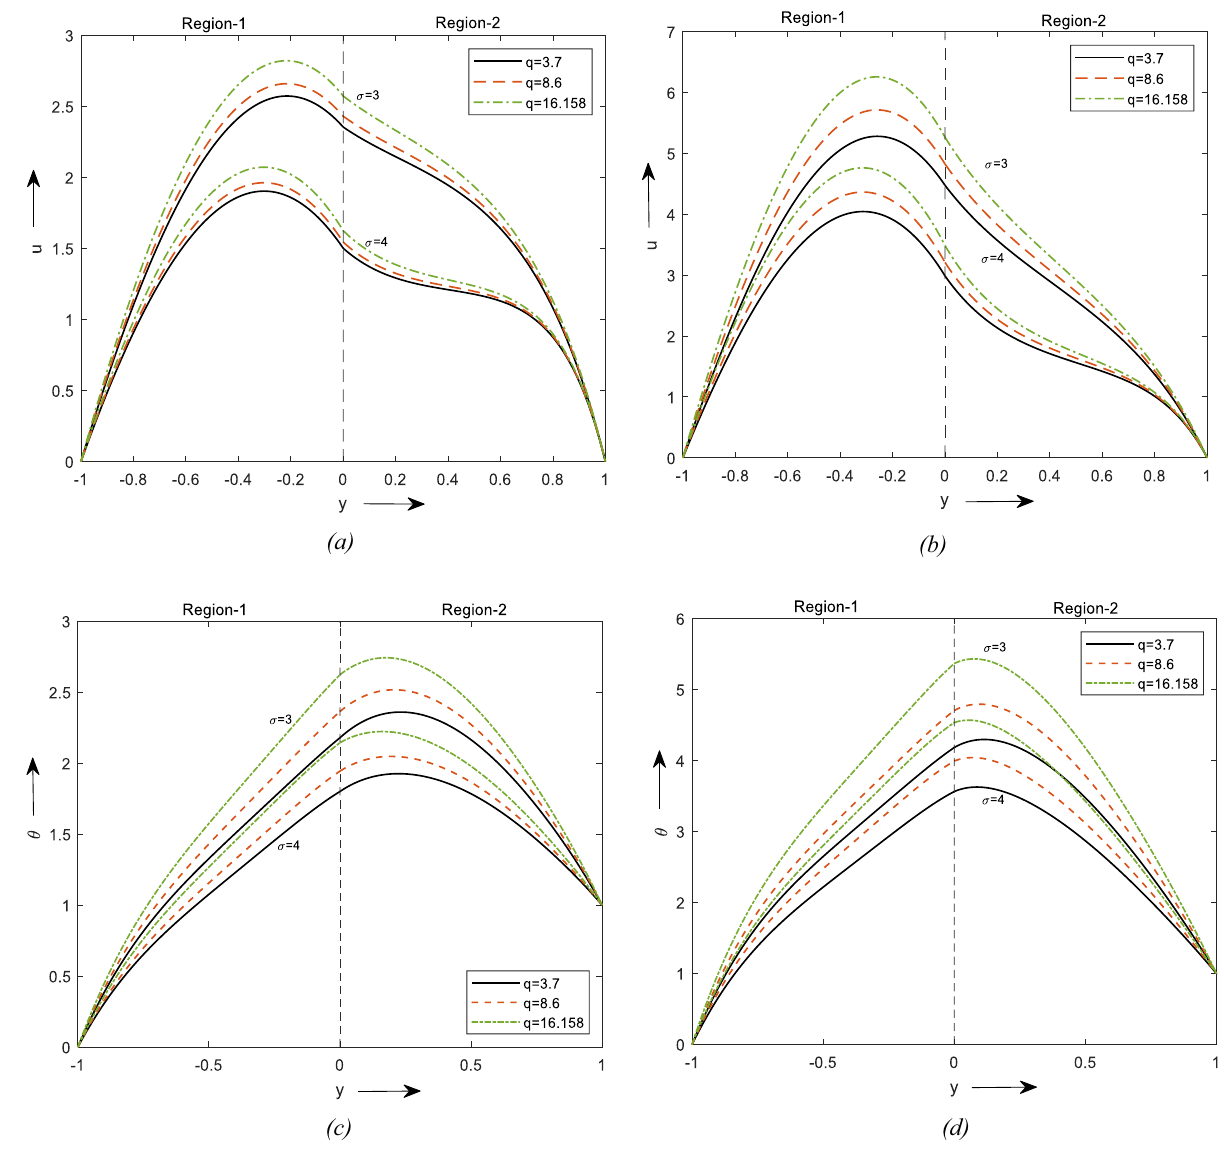
Figure 5. Velocity profiles for different values of σ . ( a ) For two different values of φ . ( b ) For a value of φ . Temperature profiles for different values of σ . ( c ) For two different values of φ . ( d ) For a value of φ